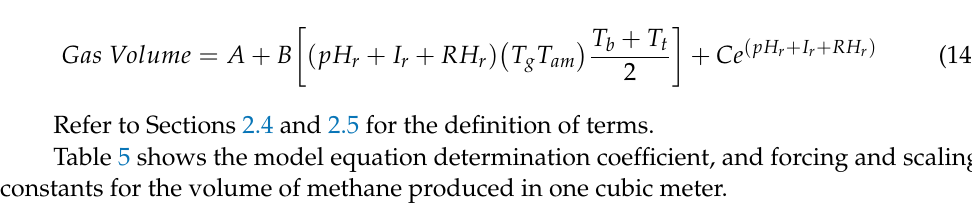
Table 5. Methane model equation constants and determination coefficient of the biogas digester. Lump Input